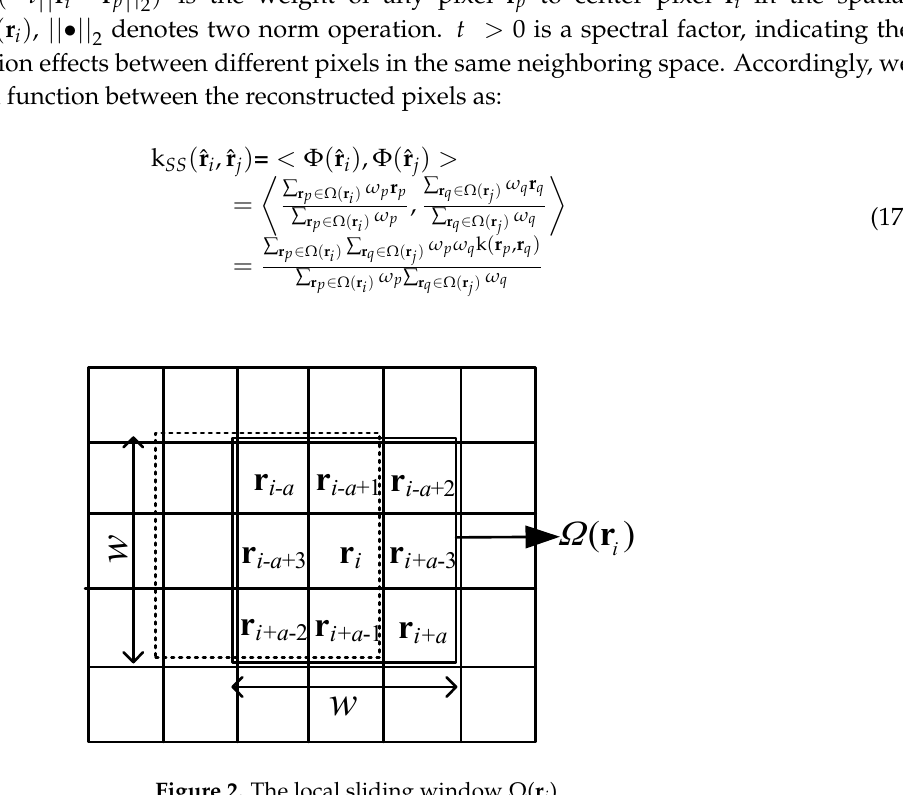
Figure 2. The local sliding window Ω ( r i ).